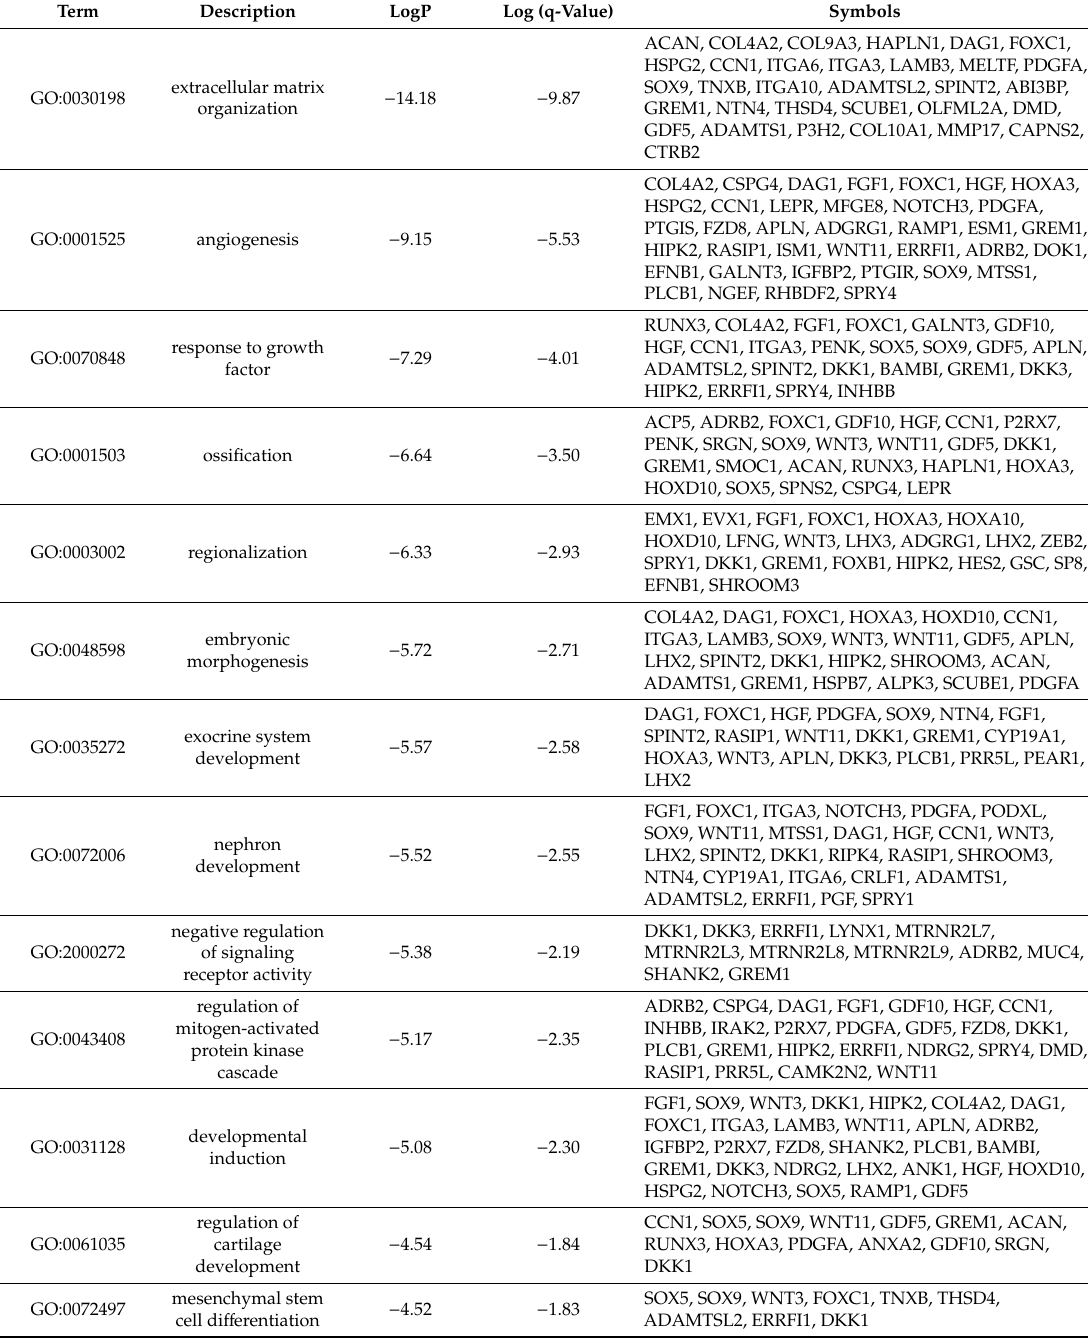
Table 1. Enriched gene ontology (GO) terms and genes fall into